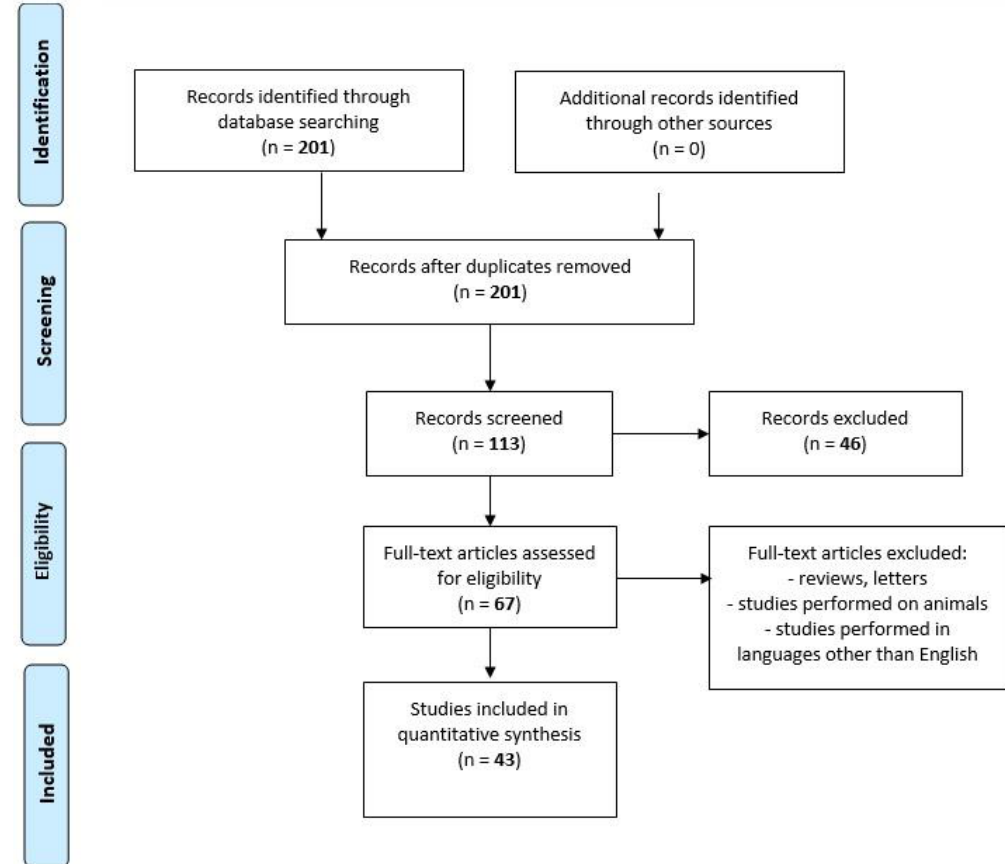
Figure 2. PRISMA flow diagram modified from Liberati et al. [74].